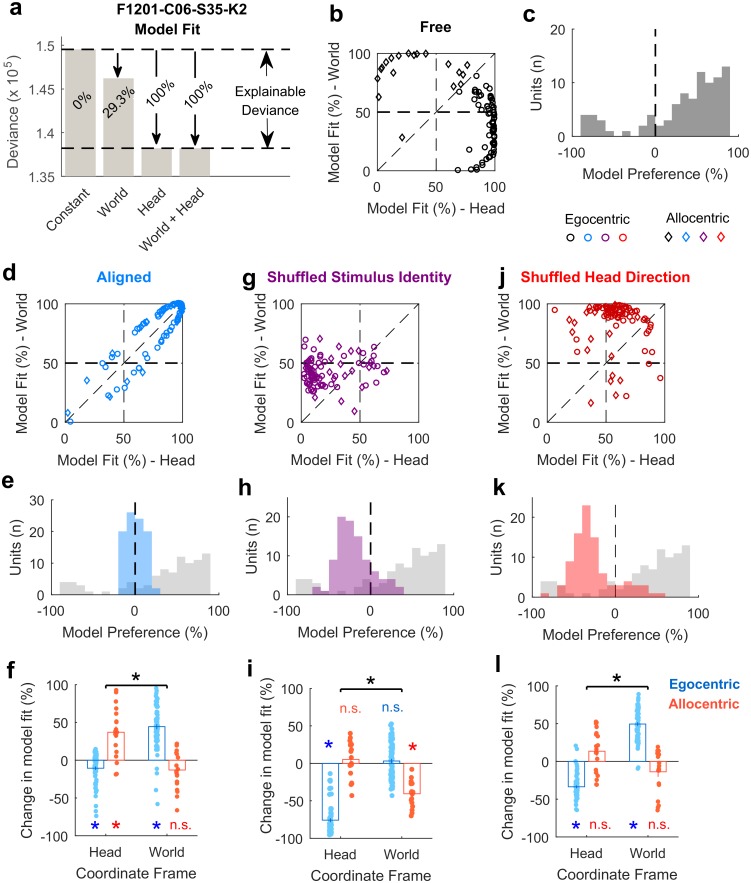
General linear modelling of spatial sensitivity.a: Calculation of model fit for sound angle relative to the head or world. Raw deviance values were normalized as a proportion of explainable deviance; the change in deviance between a constant and a full model. b: Model fit comparisons for all units when the animal was free to move through the arena. c: Model preference that indicates the distribution of units across the diagonal line of equality in (b). d-e: Model fit and model preference for data when the head and world coordinate frames were aligned. The grey background in (e) shows the distribution of model preference in the freely varying condition for reference. f: Change in model fit between freely moving and aligned states for egocentric and allocentric units in head and world coordinate frames. g-h: Model fit and model preference for freely moving data when speaker identity was shuffled. Data points in (g) show for each unit the median model fit averaged across 1,000 shuffles. i: The change in model fit between unshuffled and shuffled data. j-k: Model fit and model preference for freely moving data when the animal’s head direction was shuffled. Data points in (j) show for each unit median model fit averaged across 1,000 shuffles. l: The change in model fit between unshuffled and shuffled data. Asterisks with horizontal bars in (f), (i), and (l) indicate significant interactions (two-way anova on change in model fit with shuffle) between coordinate frame (head/world) and unit type (egocentric/allocentric) (p < 0.001). Asterisks/n.s. for each bar represent significant/non-significant effects of shuffle on model fit in specific coordinate frames and for specific unit types (red/blue; t test, p < 0.05). Data available at https://doi.org/10.6084/m9.figshare.4955360.v1.